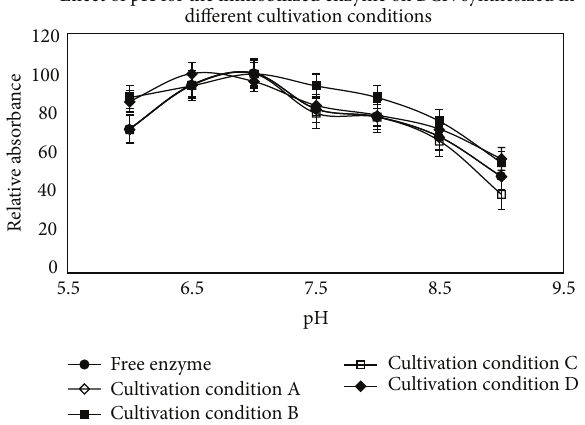
Figure 4: Effect of temperature on the free and immobilized urease activity; the relative activities at the optimum temperatures were taken as 100% for free and immobilized urease,